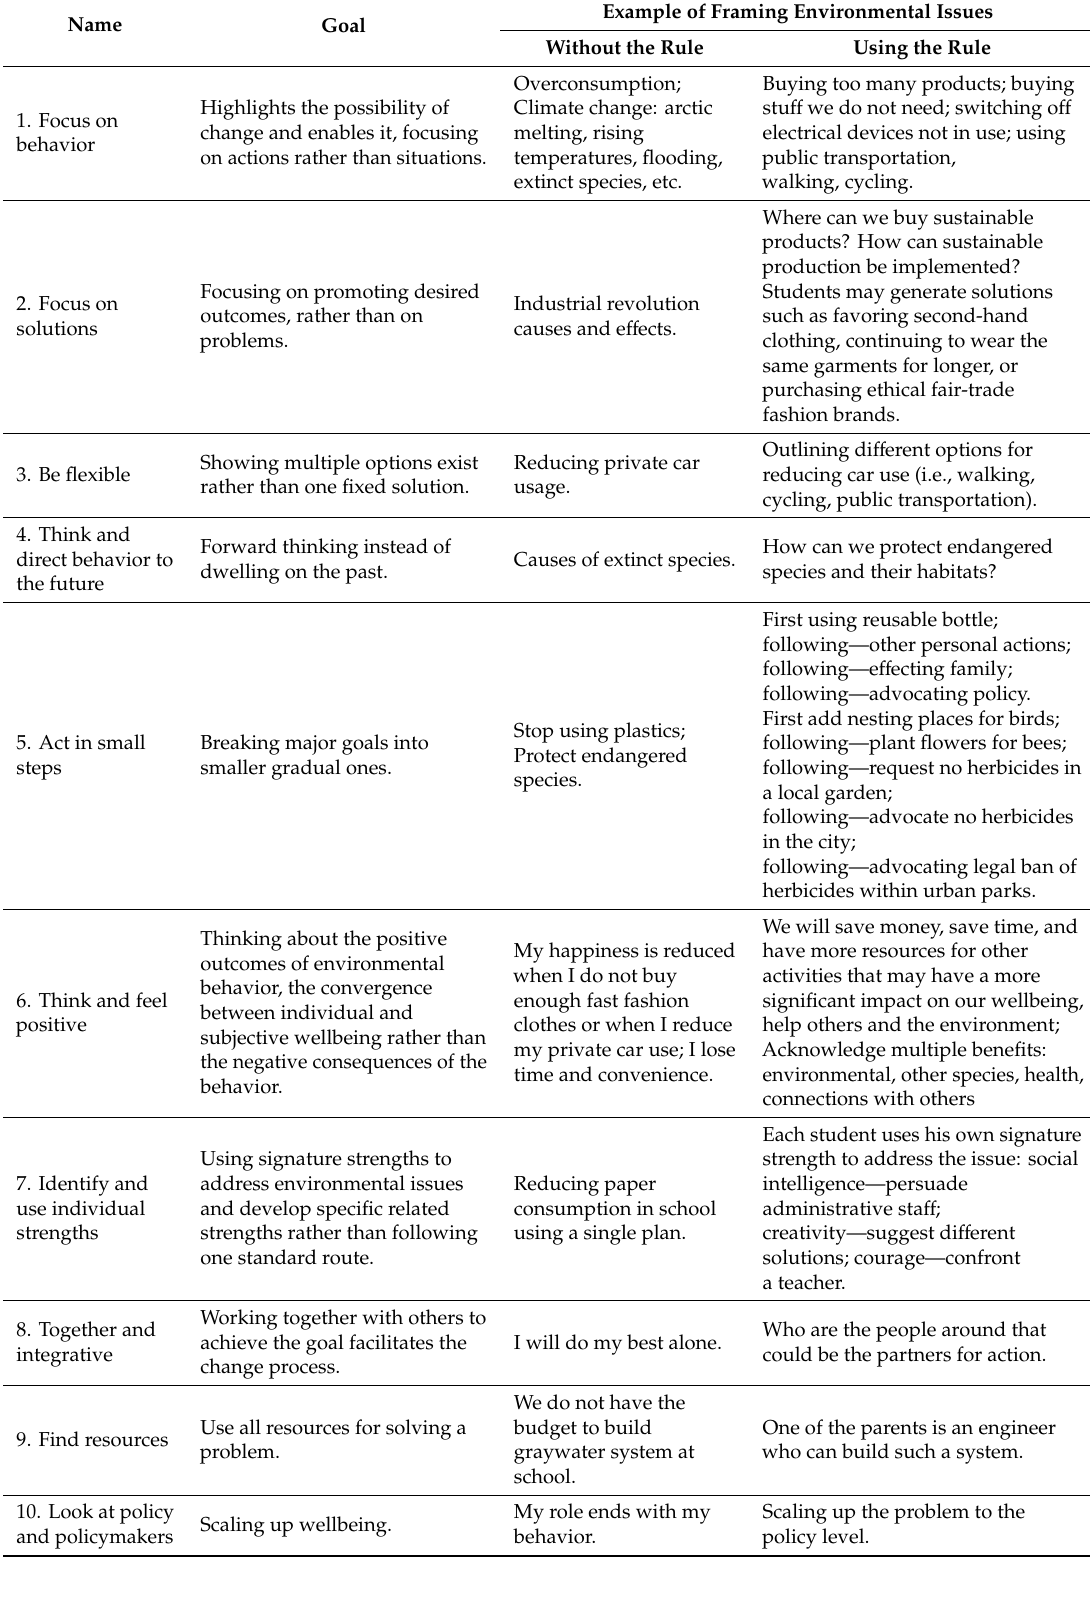
Table 2. Main characteristics of the ten thinking rules, implementing sustainable wellbeing literacy, and examples of addressing the same topics with and without the